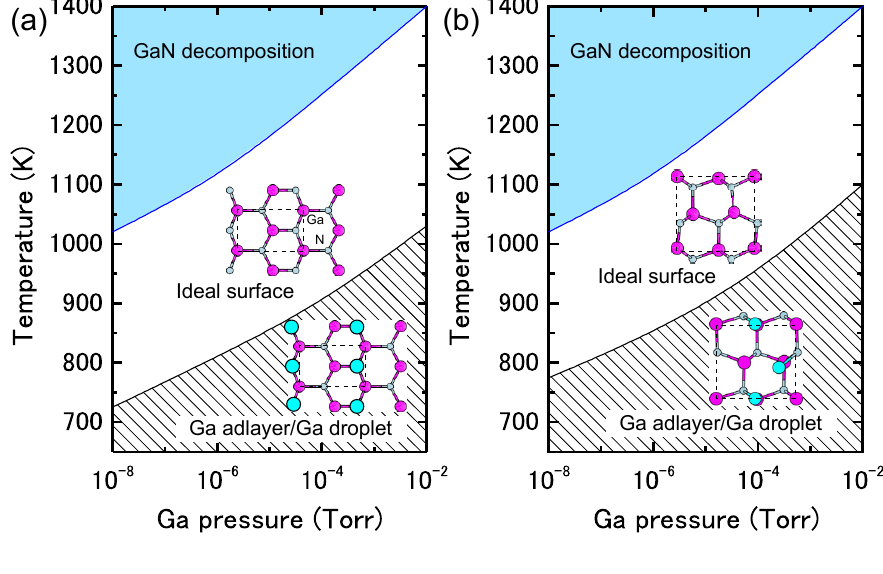
Figure 13. Calculated phase diagrams for nonpolar GaN surfaces with ( a ) (cid:4666)11(cid:3364)00(cid:4667) and ( b ) (cid:4666)112(cid:3364)0(cid:4667) orientations as a function of temperature and Ga BEP. The stable reconstructions on these surfaces are also schematically presented.